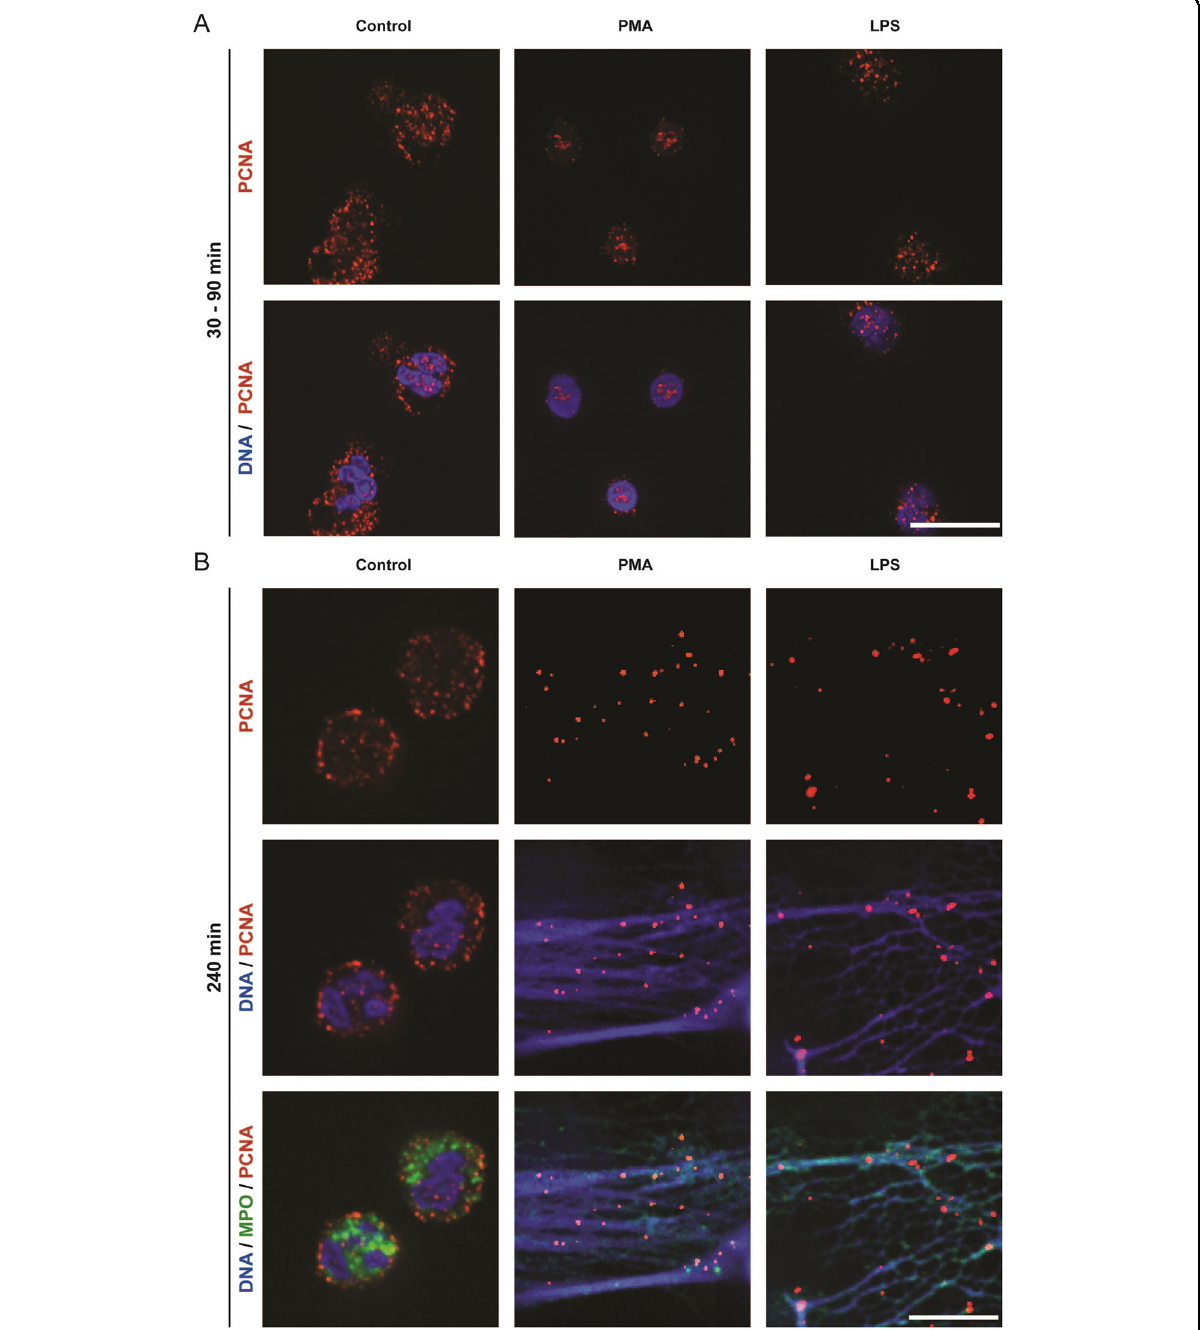
Fig. 2 PCNA translocates into the nucleus/perinuclear regions following the induction of NETosis with PMA or LPS, and eventually decorates the NET DNA. A Neutrophils were treated with PMA (25 nM) or LPS (5 μ g/ml) and incubated for 90 or 30 min, respectively. Cells were stained for DNA (DAPI, blue) and PCNA (red). B Neutrophils were treated with PMA (25 nM) or LPS (5 μ g/ml) and incubated for 240 min. Cells were stained for DNA (DAPI, blue), PCNA (red) and MPO (green). The images are representative of three independent experiments. Scale bar, 10 μ